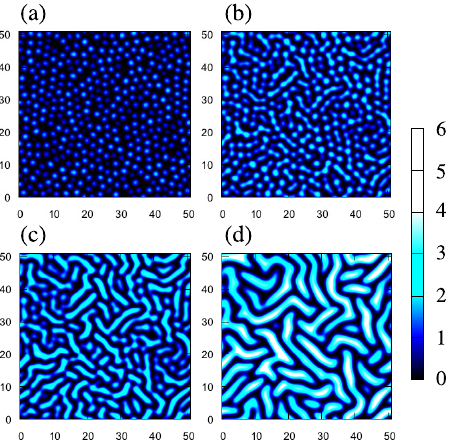
Figure 6. Snapshots of numerical simulations at ( a ) t = 120, ( b ) 160, ( c ) 200, and ( d ) 400. The color scale illustrates the mid-plane displacement w . Panels ( a , b ) correspond to ( c – f ) of Figure 1, respectively. The length of a side of a snapshot corresponds to 6.8 mm when the film thickness is h = 0.13 mm.